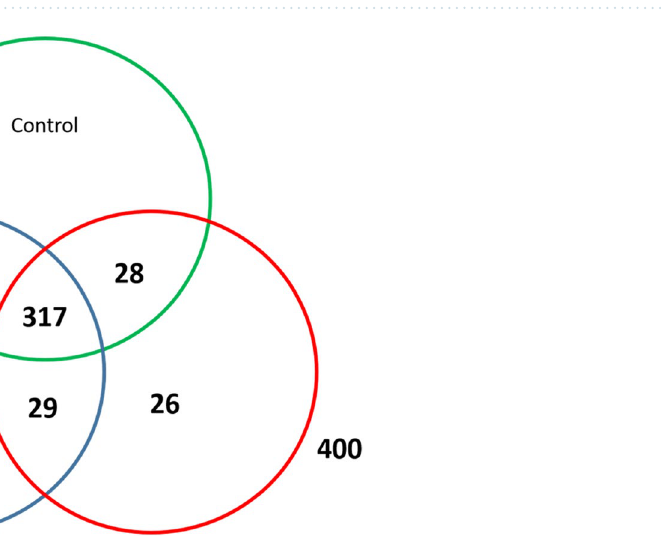
Figure 5. First nucleotide bias of the conserved and novel miRNAs at the three libraries. From up to down: Control, Test 1 and Test 2. Most miRNAs were started with 5 ʹ -U and not with 5 ʹ -G. This issue is in agreement with common mammalian miRNA sequence patterns.